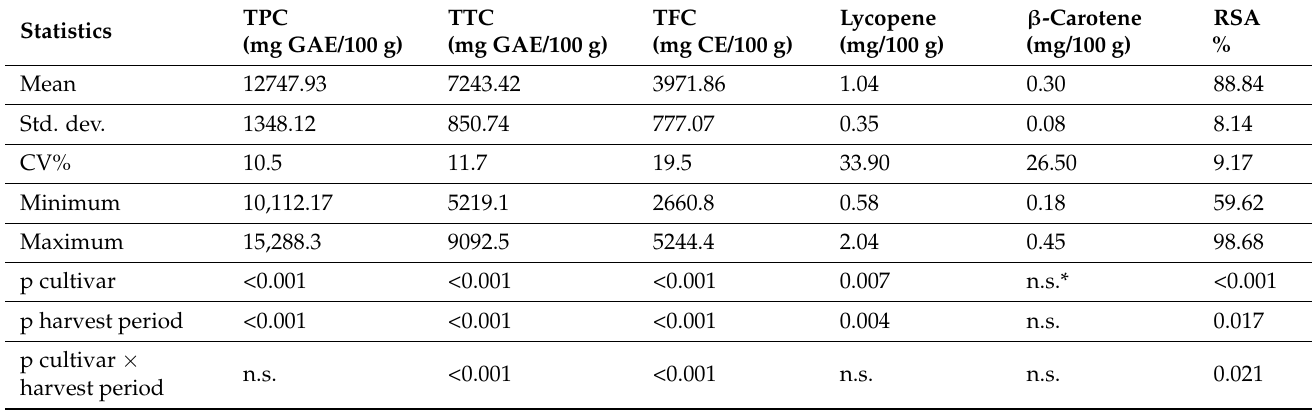
Table 1. Mean values, standard deviation, variation coefficients, and limit values of total